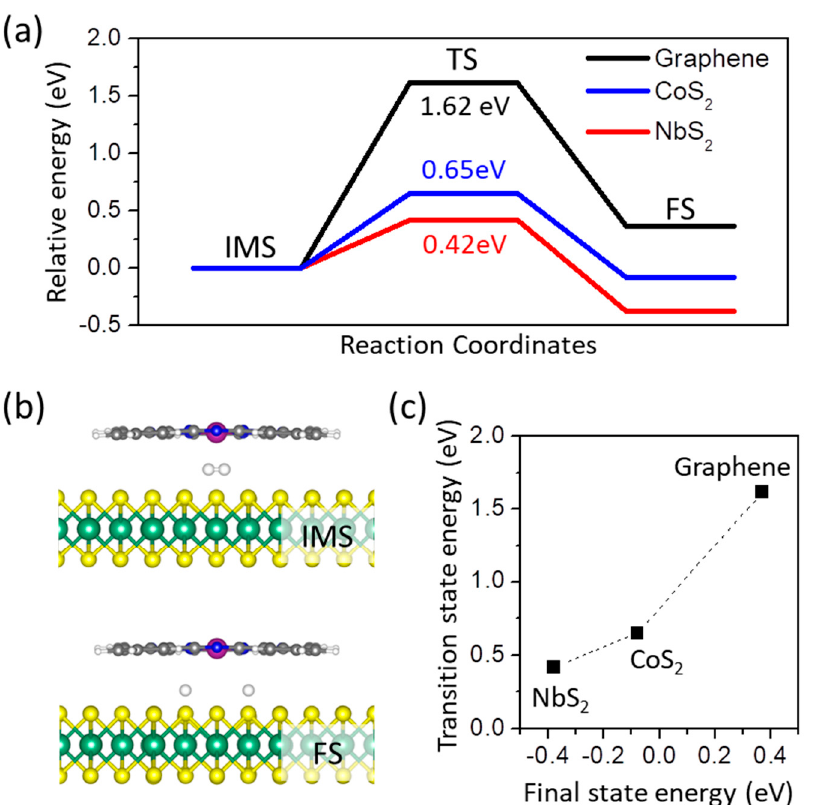
Figure 4. ( a ) Reaction pathway of hydrogen dissociation between an MnPc molecule and a monolayer of 2D materials. ( b ) Side views of intermediate and final state of hydrogen dissociation in an MnPc / NbS 2 system. ( c ) Transition state energy as a function of the final state energy in a quantum nutcracker.